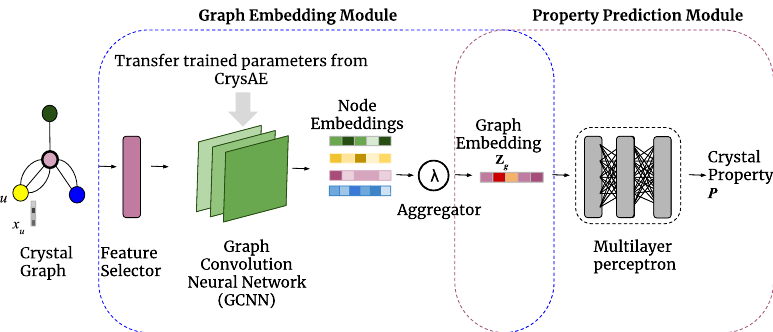
Fig. 1 Architecture of Crystal eXplainable Property Predictor (CrysXPP). It comprises two building blocks. Graph embedding module and Property prediction module. Given graph structure and node feature information, graph embedding module produces an embedding corresponding to each graph. Property predictor is a deep regressor module, which takes graph embedding as input and predicts the property value.